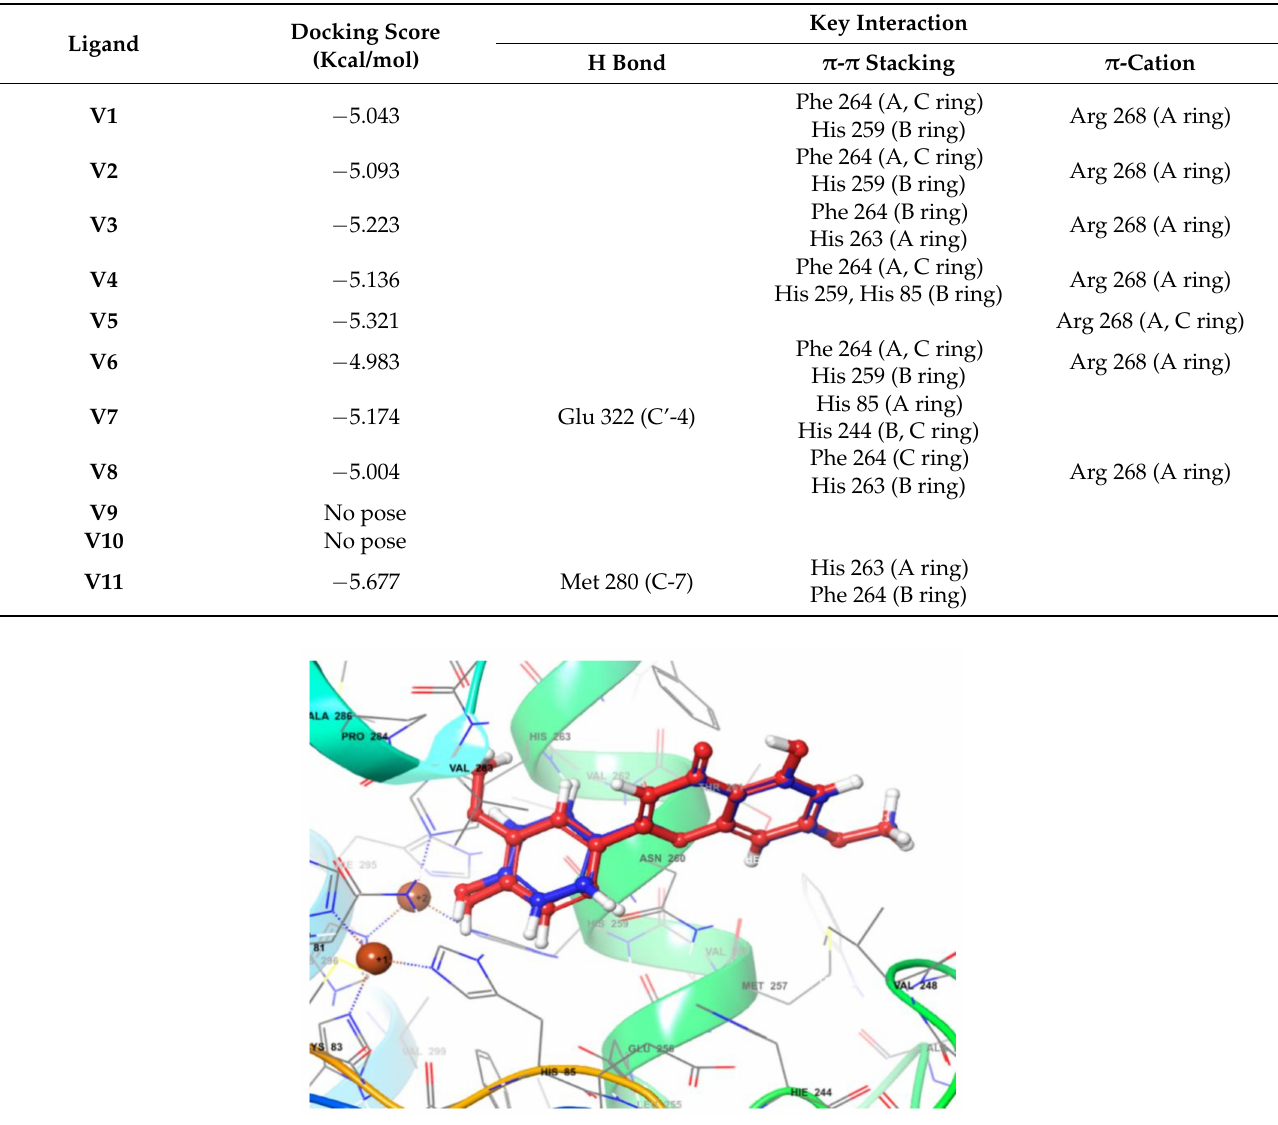
Figure 4. Molecular docking of tyrosinase binding with the V1 and V4 derivatives ( V1 : red sticks and V4 : blue